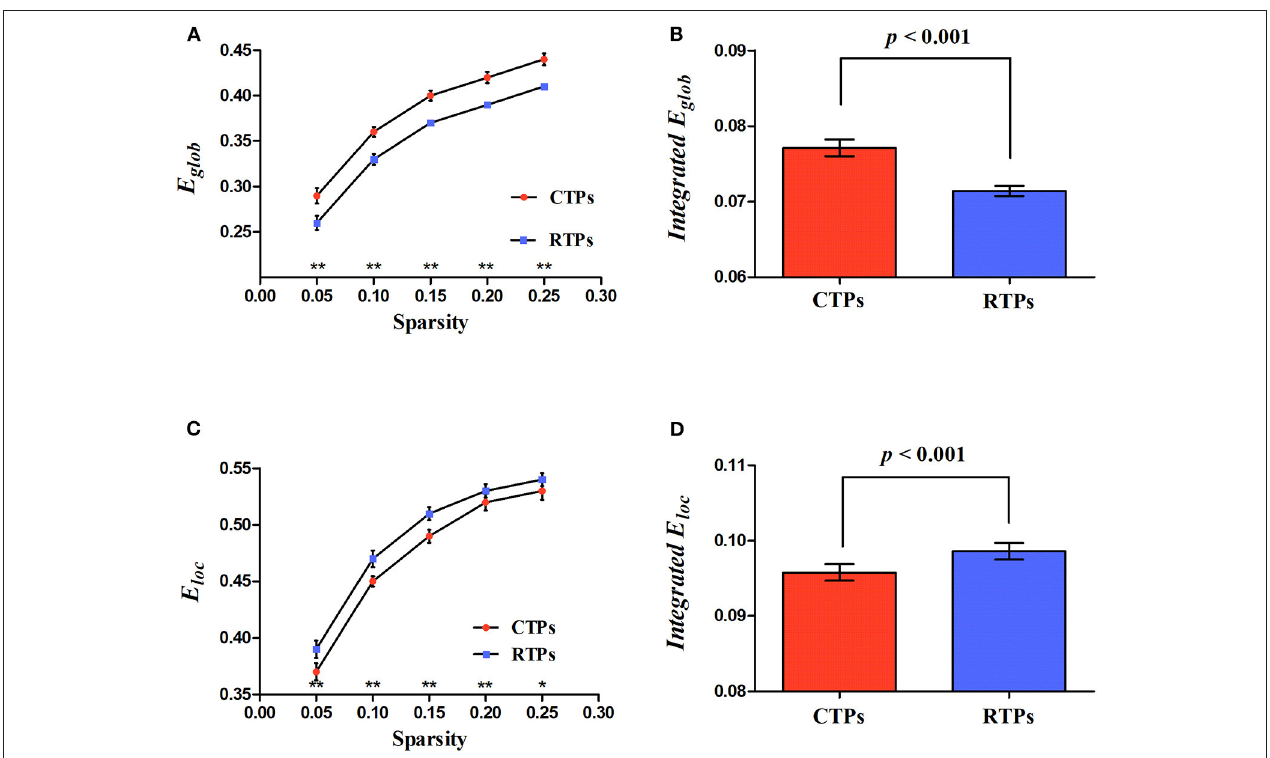
FIGURE 3 | Illustration for the global parameters changing with sparsity (A,C) and significant differences in integrated network parameters (B,D) at resting state. E glob , global efficiency; E loc , local efficiency. The asterisk (* and **) indicates a significant between group difference at p < 0.05 and p < 0.01.